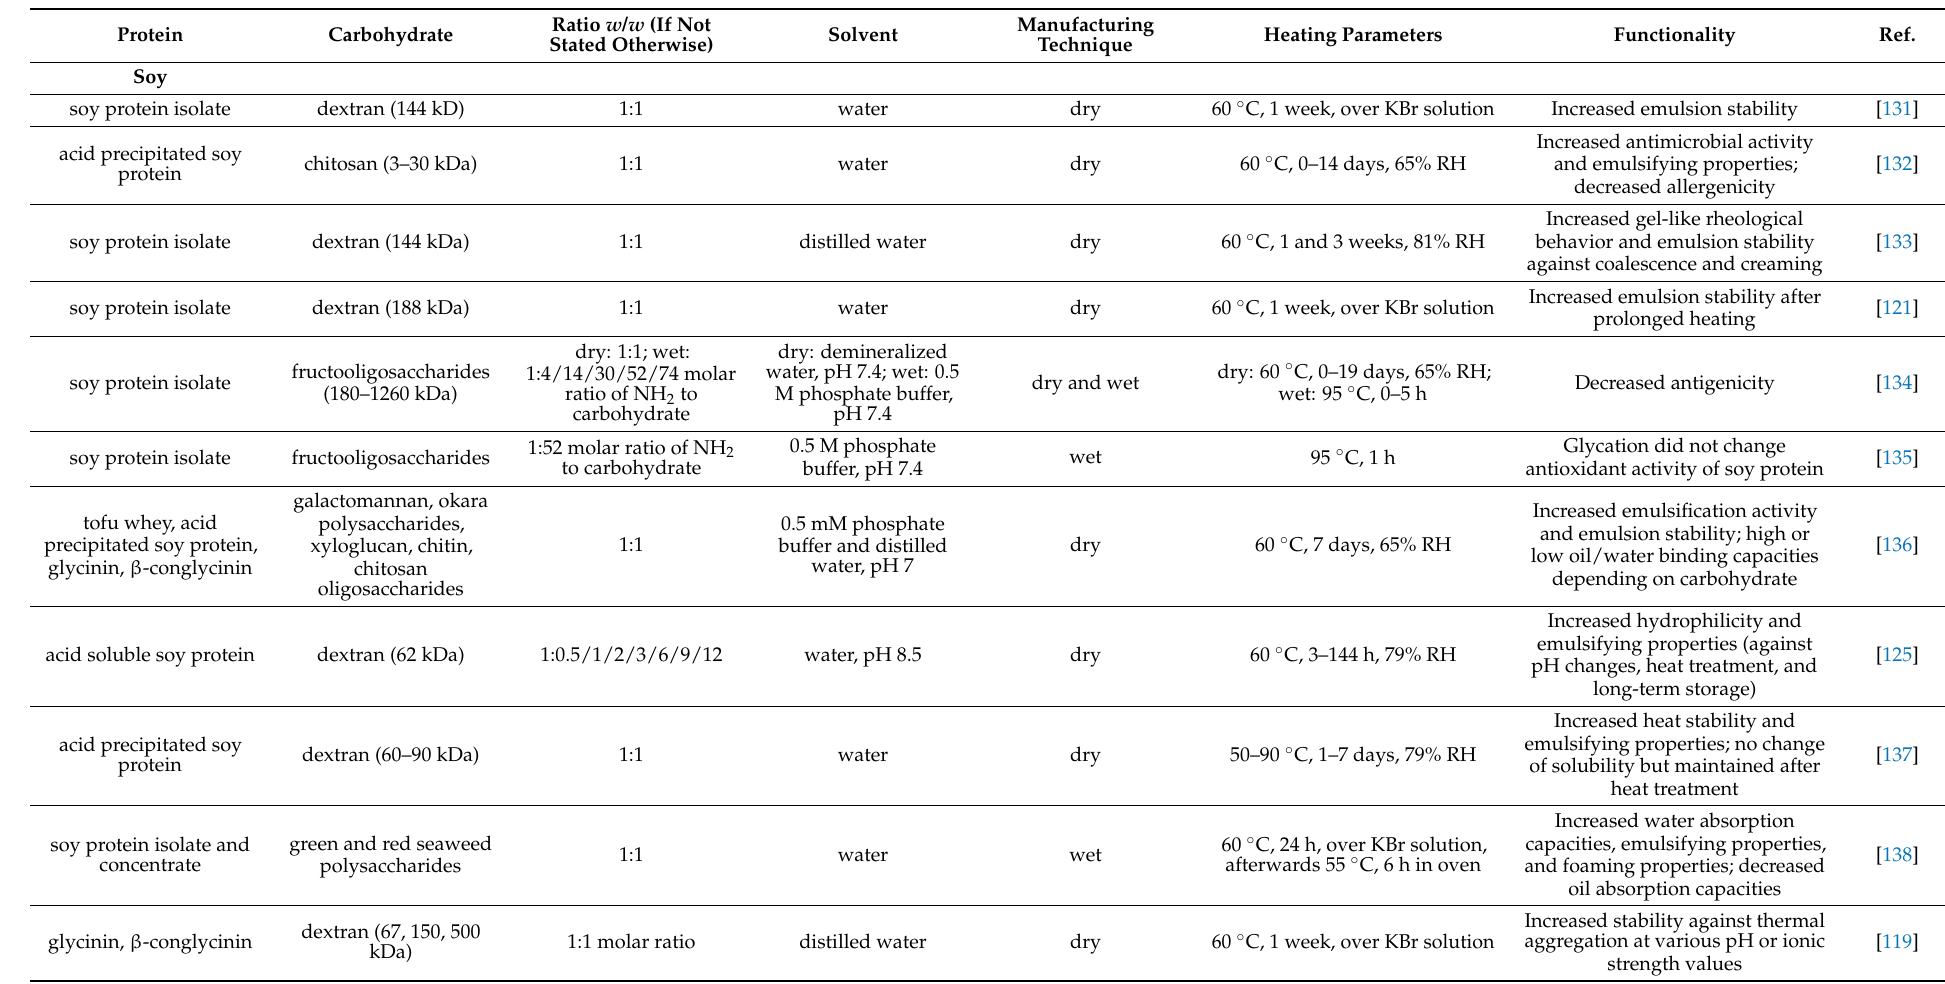
Table 1. Overview of proteins from grain legumes glycated with various carbohydrates under different reaction conditions and their functionalities.